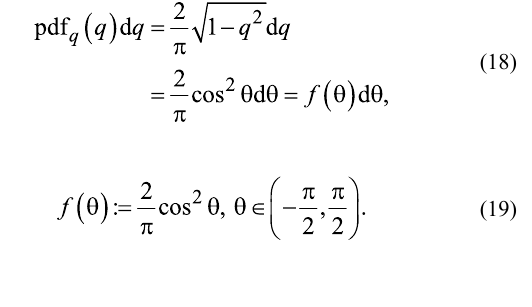
Considering the displacement of a molecule in the vertical direction along the axis of the nanocylinder, the only angle that is explicitly significant to the phenomenon is the angle in the vertical plane θ , which fulfils the